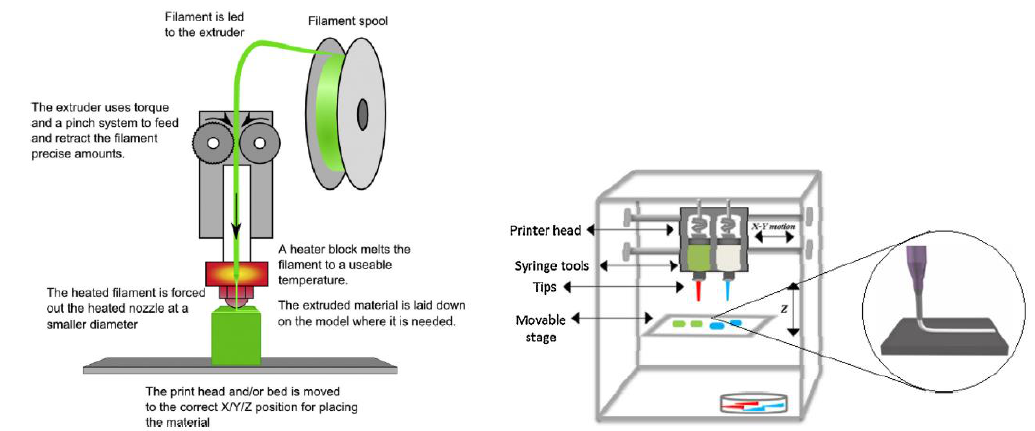
Figure 2. Schematic representation of fused deposition modeling (FDM) ( left ) (from Khatri et al., [2], with permission) and pressure-assisted microsyringe (PAM) ( right ) systems (from Goole and Amighi, [16], with permission)